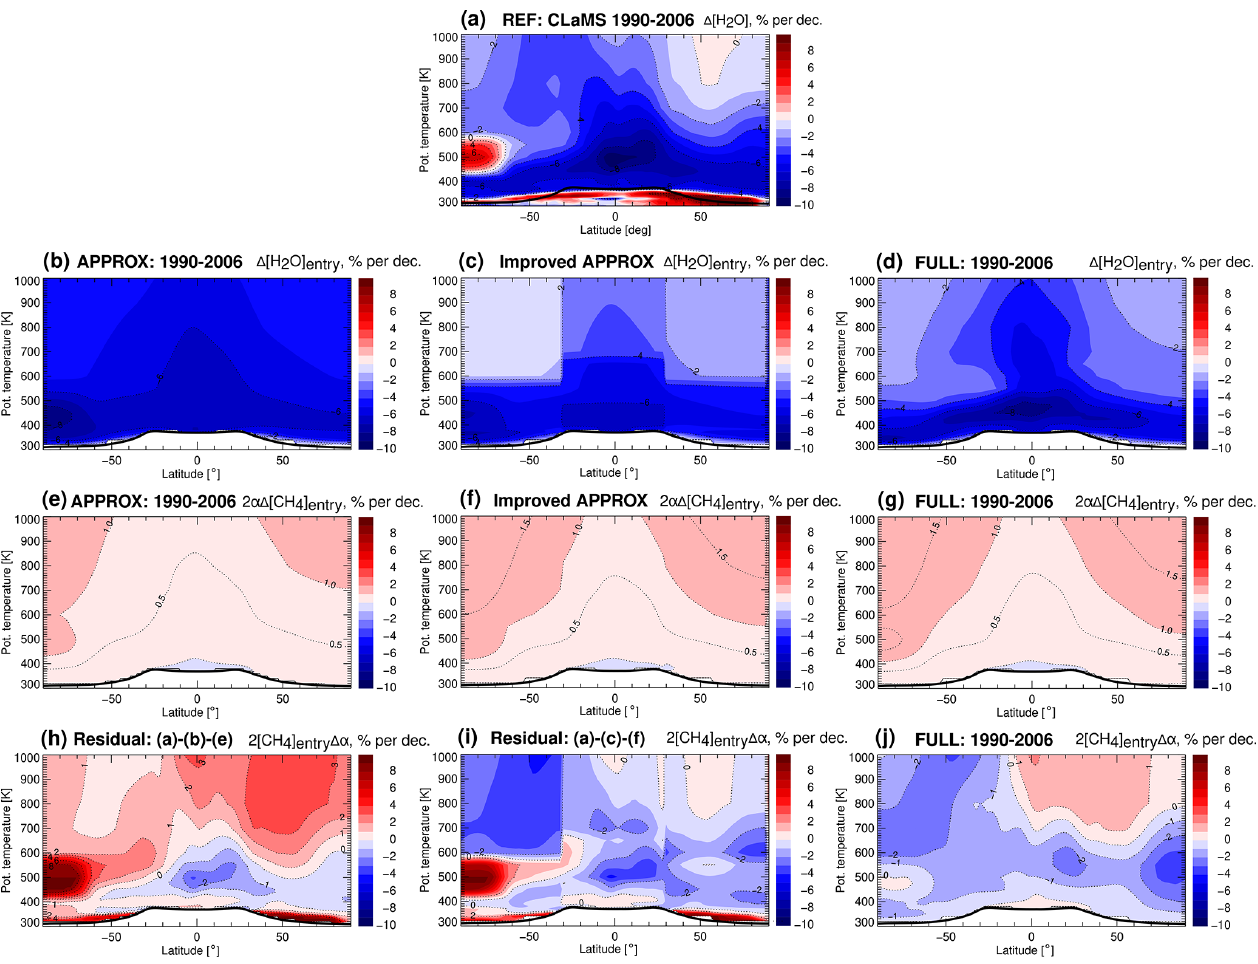
Figure 8. Contributions to H 2 O trends during 1990–2006. The true stratospheric H 2 O 1990–2006 trend calculated from CLaMS simulations driven by ERA-Interim reanalysis is shown in (a) . Further plots represent contributions to H 2 O trend calculated through different methods: APPROX (b, e, h) , the improved approximation (c, f, i) , and FULL (d, g, j) . The contributions from circulation changes are calculated as the residual in APPROX and improved approximation methods (h, i) and as a linear trend in FULL (j) . Note that all panels are presented in percentage per decade, with relation to the climatological mean 1990–2006 CLaMS stratospheric H 2 O mixing ratio. The black line is the tropopause calculated from